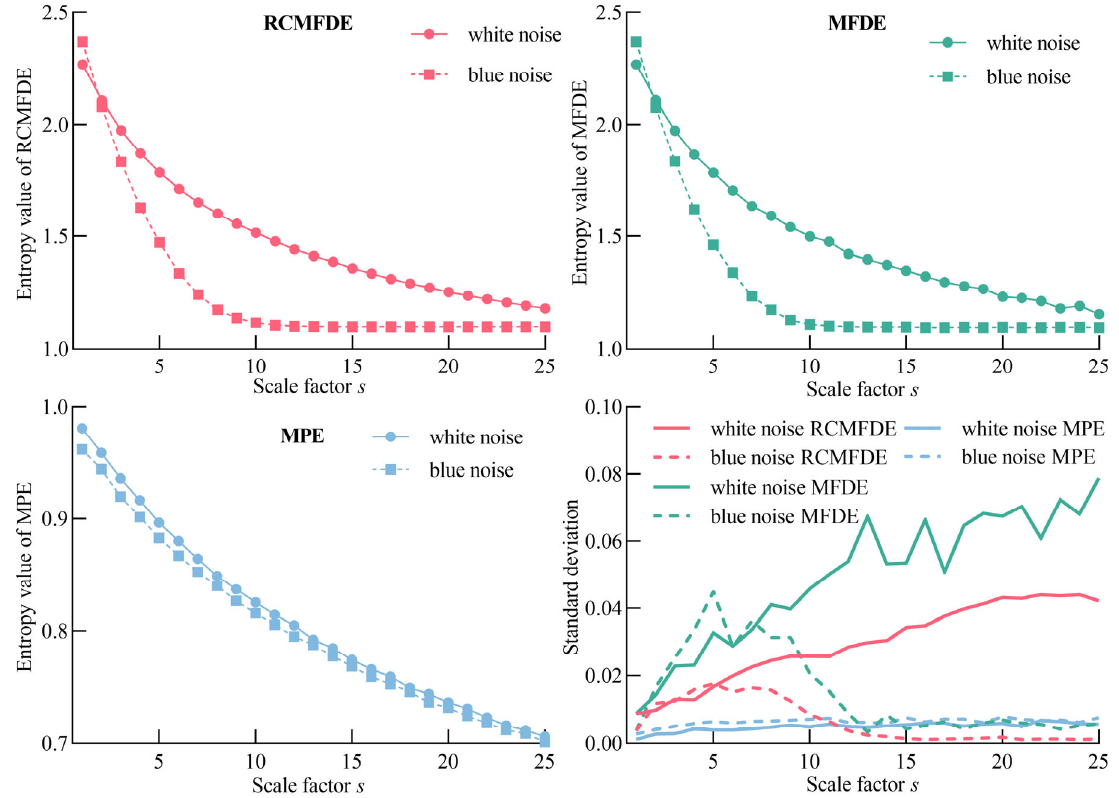
Figure 7. Comparison results of different entropy theories.